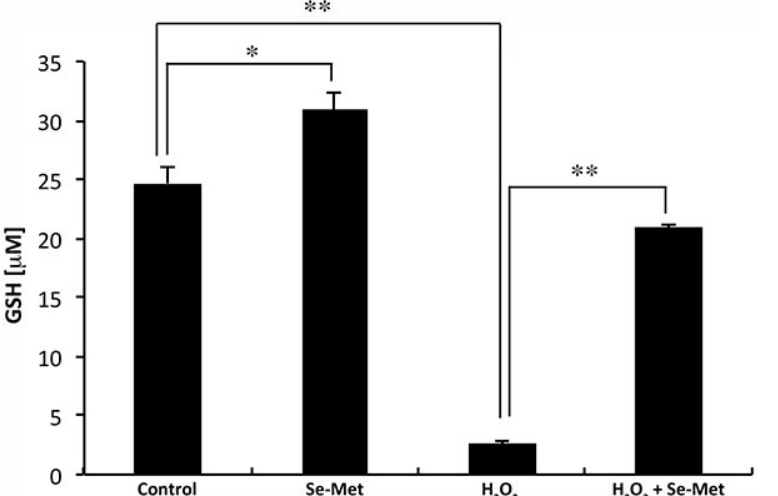
Figure 7. Se-Met raises intracellular levels of glutathione (GSH) protecting ARPE-19 cells against H 2 O 2 -induced GSH depletion. Oxidative stress was induced in ARPE-19 cells using hydrogen peroxide (H 2 O 2 , 500 µ M) in the presence or absence of Se-Met (1 mM). Intracellular levels of glutathione (GSH) were then measured using the GSH-Glo Assay kit (Promega). (* p < 0.01; ** p < 0.001).